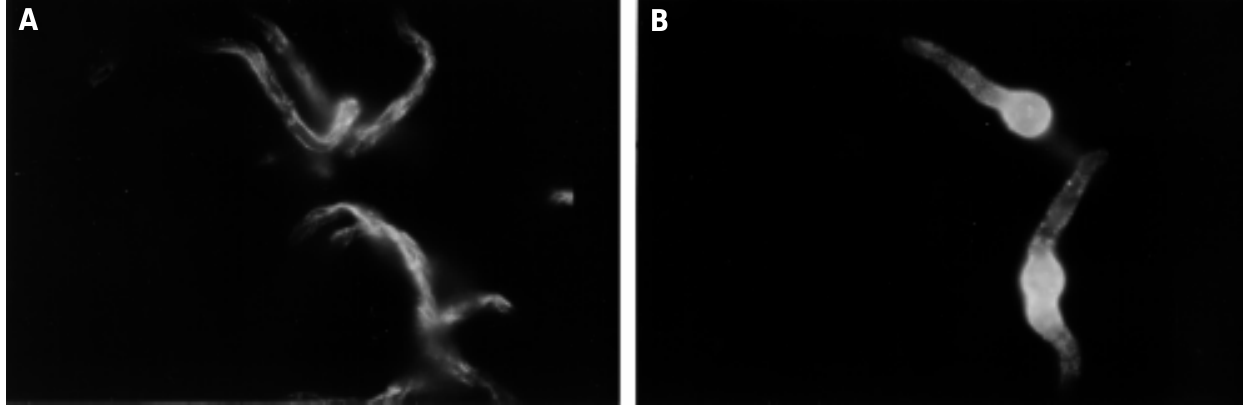
Figure 2 - Indirect immunofluorescence microscopy of the microtubule cytoskeleton structure in control (A) and in germlings of R21 strain of Aspergillus nidulans exposed to Benomyl for 90 min (B). Note the depolymerization of microtubules in Benomyl-treated